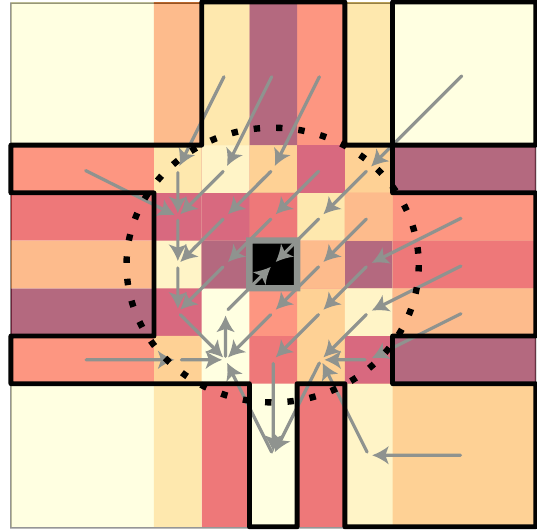
Figure 4. Monte Carlo generation procedure: (i) a spatially cor- related Gaussian field with an exponential covariance function (mean=30, partial sill=8, nugget=2, range=3) is generated along a 7 × 7 irregular grid. The central pixel (in black) represents the downstream-most catchment, where runoff is to be predicted. Among the remaining pixels, 24 inner isolated drainage areas (IDA) are within a radius of one spatial correlation range (dashed circle) of the central pixel, and 24 outer pixels are beyond that radius. (ii) A predefined number of inner and outer pixels are randomly selected as part of the set of catchments that are flow-connected to the cen- tral pixel. In the figure, all 24 inner pixels and 12 outer pixels are selected and form the flow catchment outlined with a thick black line. (iii) A tree graph is randomly generated (grey arrows) with its trunk at the prediction pixel and branches passing through all the flow-connected pixels. The random field generated in step one is aggregated along the tree by summing the value of all lower order branches at each confluence. (iv) A new spatially correlated field (mean=1, partial sill=0.15, nugget=0, range=0.5) is generated at each pixel – that is the observed trend. The trend is multiplied by a predefined trend coefficient ( τ = 10) and added to the aggregated runoff at each pixel – that is the observed runoff. (v) Based on the observed runoff and (if applicable) trend at the 48 non-central pix- els, TopREML and the compared baseline method (Top-kriging or universal kriging) are used to predict runoff at the central pixel. Pre- diction errors are recorded and the procedure repeated 1000 times to get the mean and variance of the